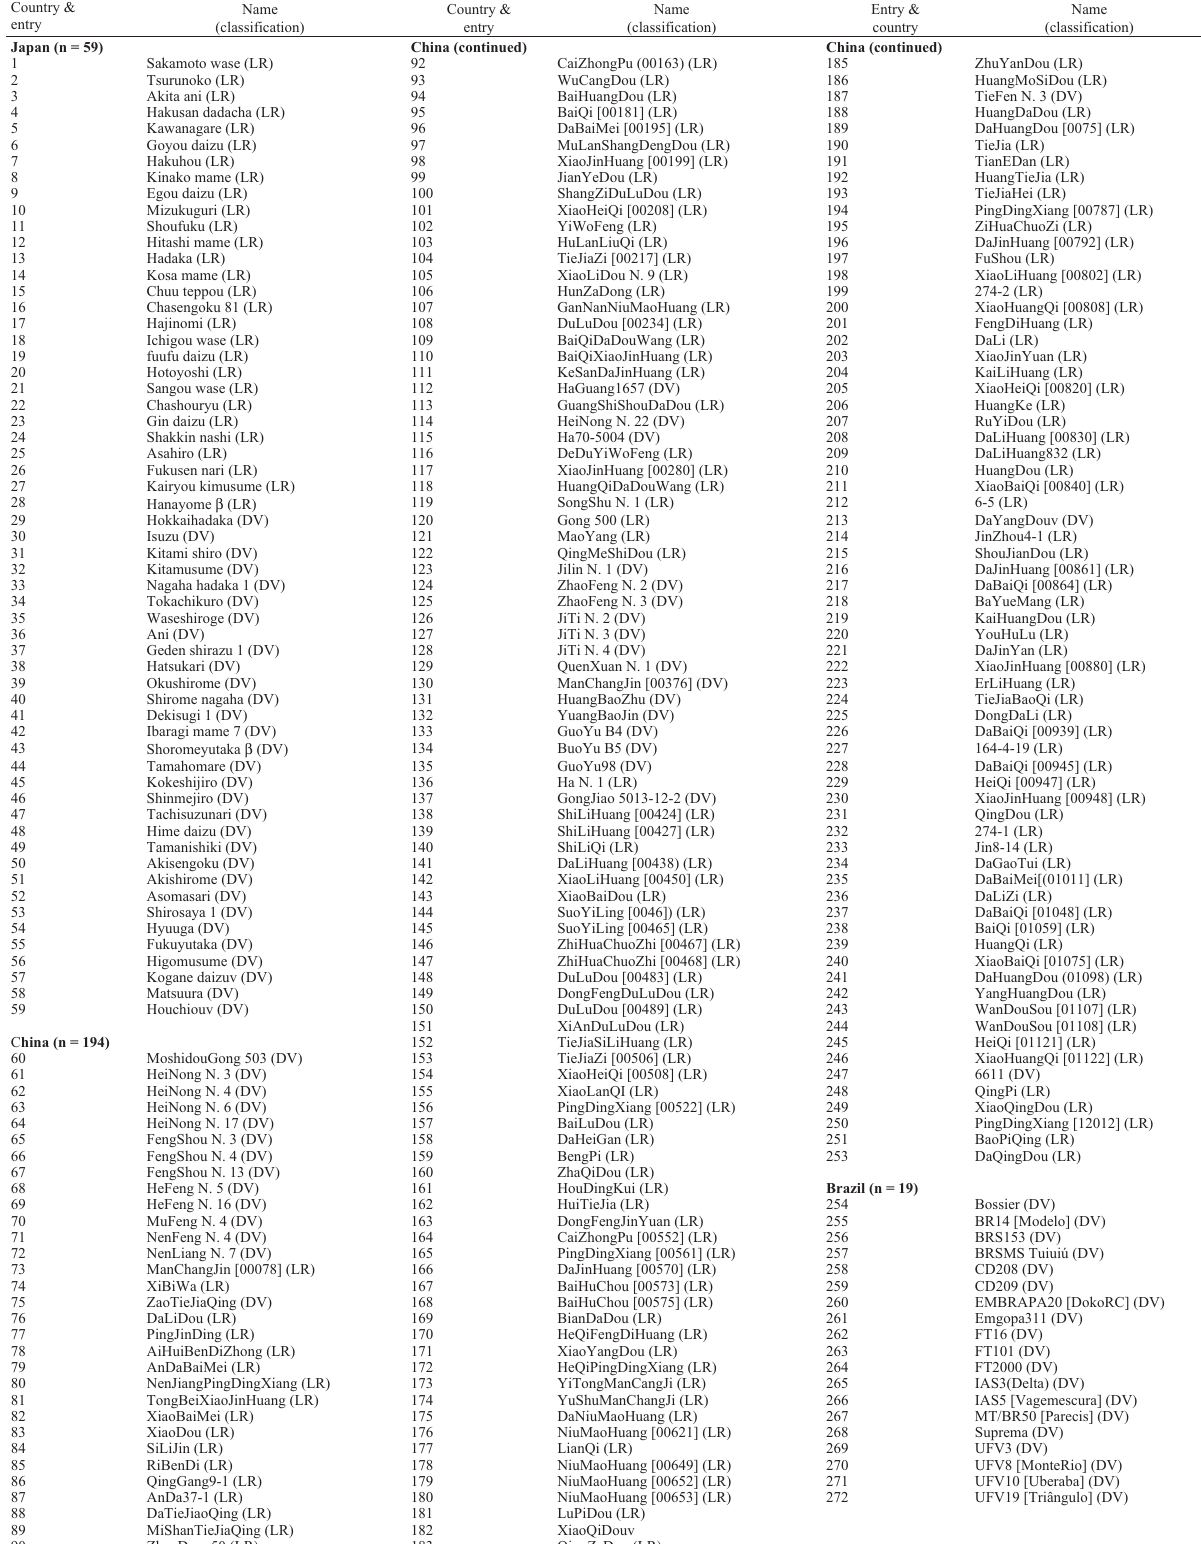
Table 1 - Soybean cultivars (n = 272) used in this study. Chinese cultivars with the same names are distinguished by their China national ID number in square brackets [ZDD number]. Brazilian cultivars have their alternative name in square brackets. The classification of the cultivars are shown in parenthesis as landrace (LR) or developed variety